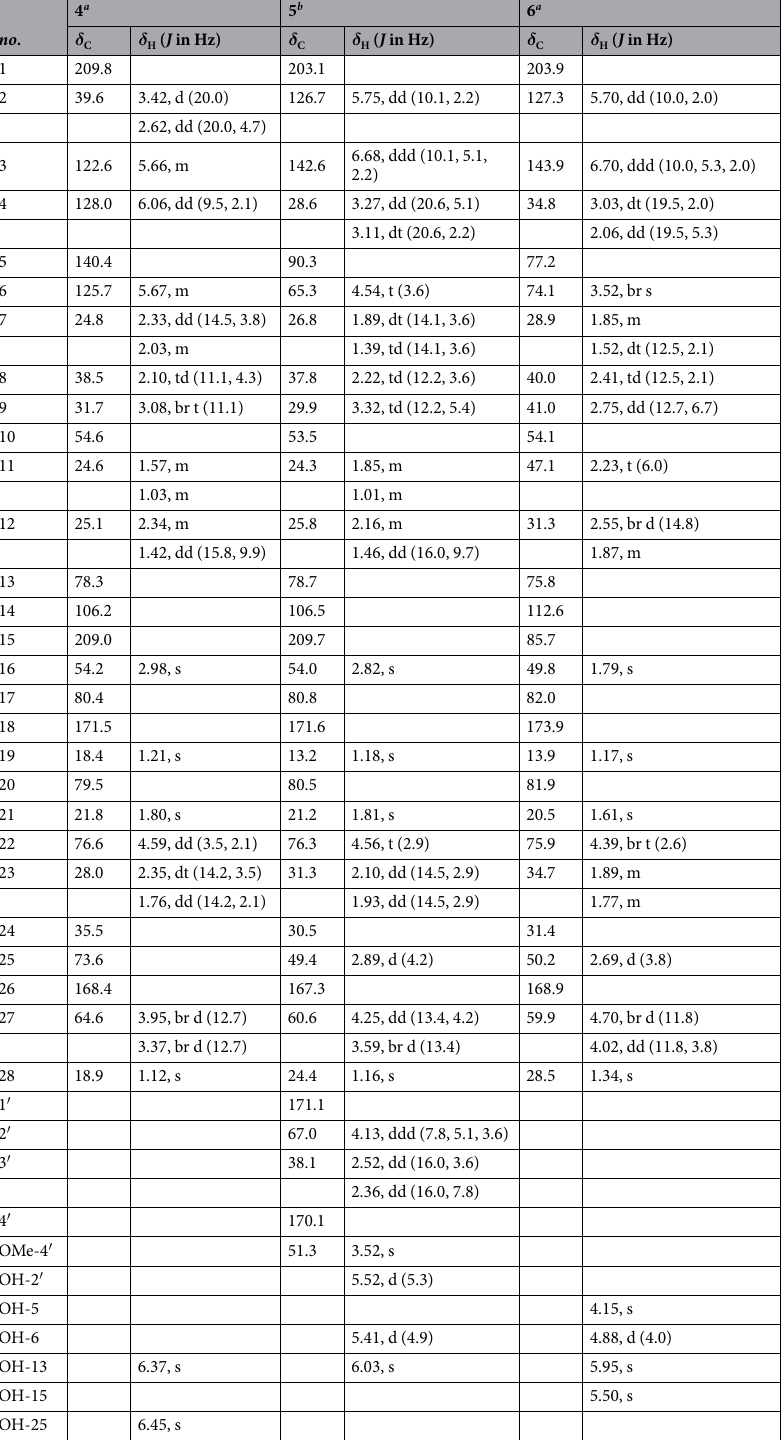
Table 2. 1 H and 13 C NMR data of compounds 4 − 6 . a 1 H NMR spectra recorded at 600 MHz, 13 C NMR spectra recorded at 150 MHz, DMSO- d 6 . b 1 H NMR spectra recorded at 600 MHz, 13 C NMR spectra recorded at 100 MHz, DMSO- d 6